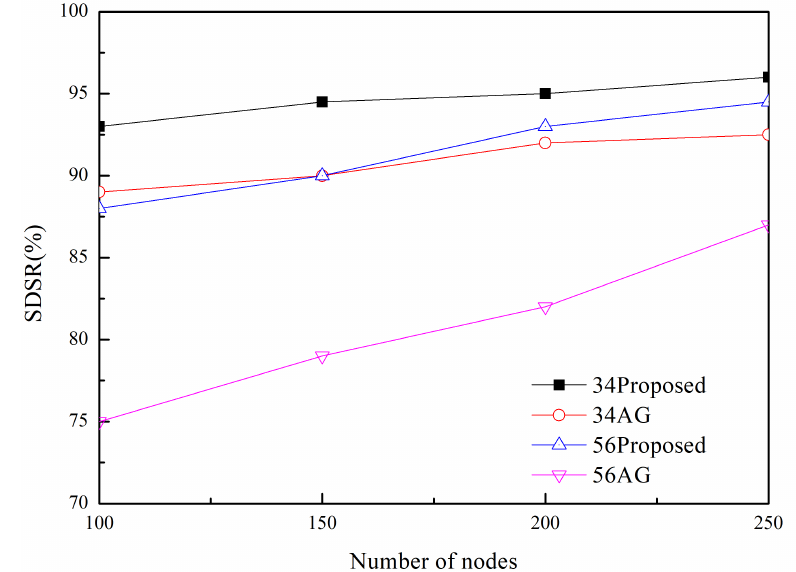
Figure 7. SDSR in (2,3)-firm application as a function of node density.